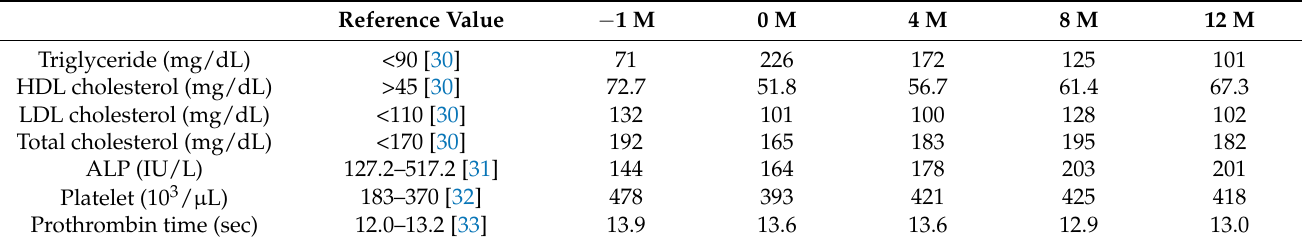
Table 1. Blood laboratory findings before and after the cord blood cell